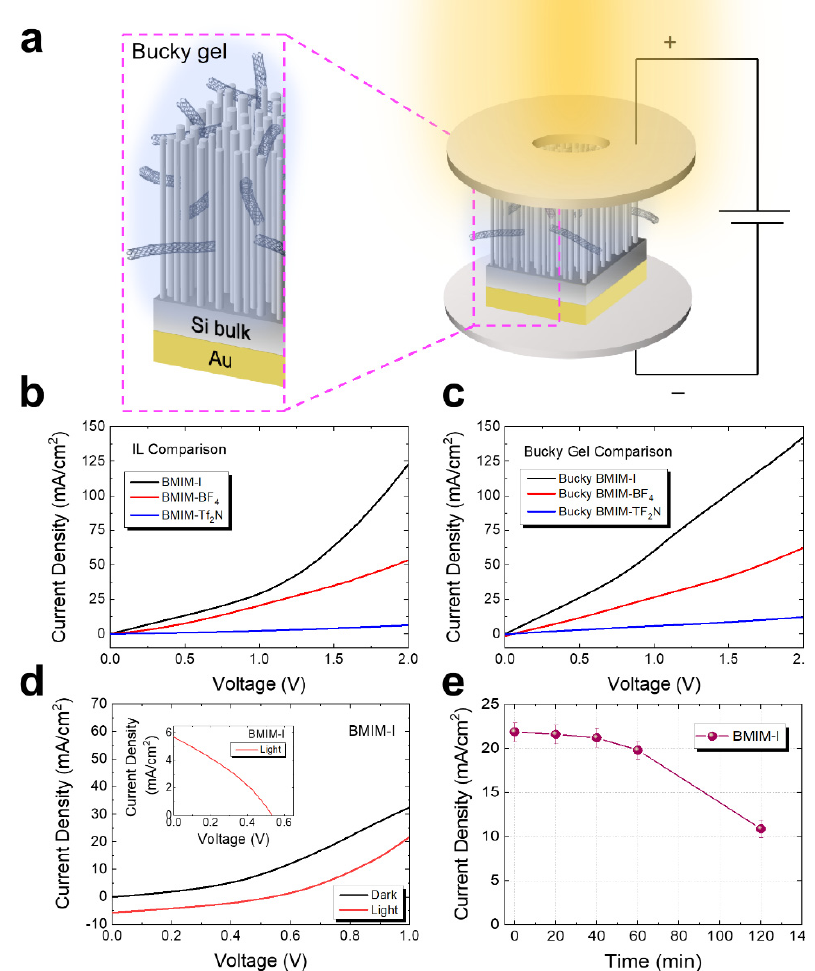
Figure 5. ( a ) Scheme depicting the realization of the hybrid CNT/NW platform and its electrical characterization in a sealed cell under dark and illumination conditions. The current densities are reported for the BMIM-I (black line), BMIM-BF 4 (red line), and BMIM-TF 2 N (blue line) and ( b ) simple ionic liquids and ( c ) CNT bucky gel without the NWs for comparison. ( d ) Current density for the hybrid CNT/NW platform based on a BMIM-I matrix under dark (black line) and illumination conditions (red line). ( e ) Time stability of the photovoltaic response of the hybrid BMIM-I CNT/NW platform at a bias of 1 V under illumination at a power of 100 mW/cm 2